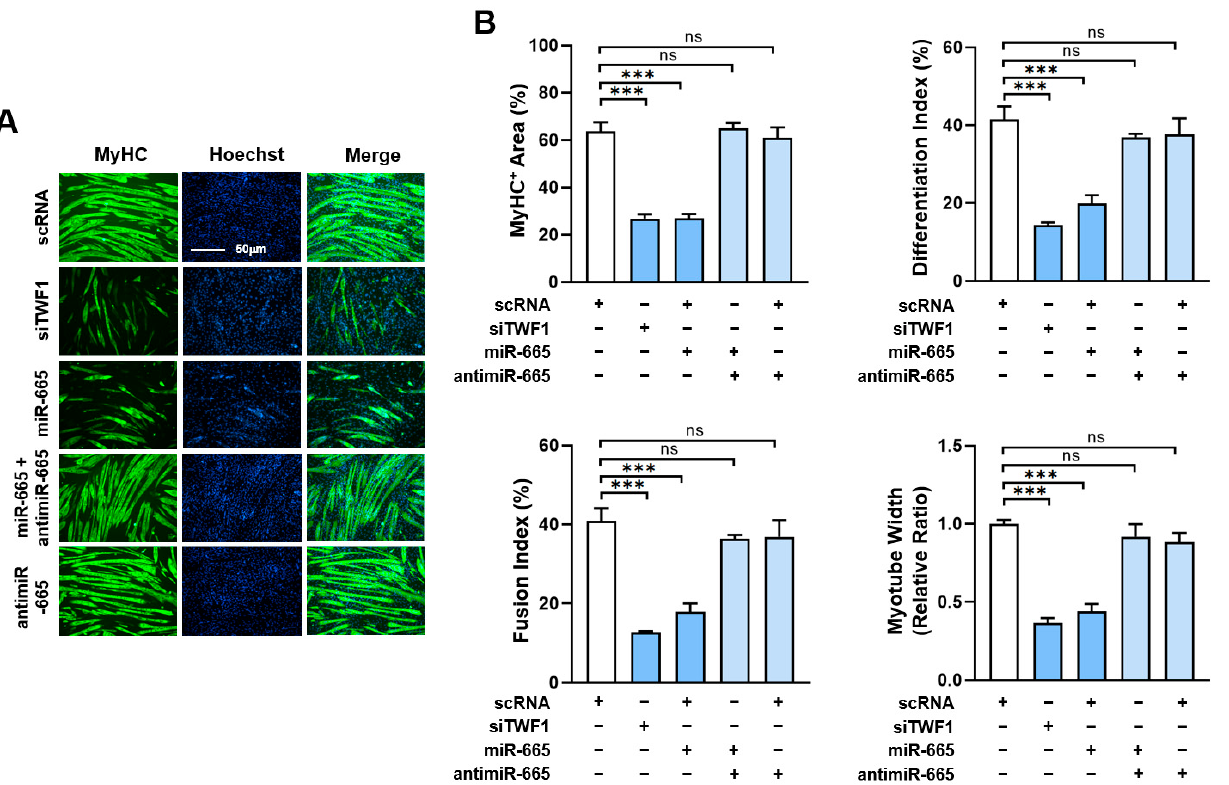
Figure 6. MiR-665-3p reduced myotube formation. C2C12 myoblasts were transfected with miR- 665 mimic, antimiR-665, siTWF1, or scRNA control (200 µ M) and then differentiated for five days. ( A ) Immunofluorescence staining (MyHC, green) was used to assess levels of differentiation of myoblasts. Nuclei were counterstained with Hoechst 33,342 (blue). Scale bar: 50 µ m. ( B ) Myotube formation was quantified based on the results of ( A ) for MyHC-positivity, differentiation indices, fusion indices, and myotube widths. Results are expressed as the means ± SEMs ( n = 3; *** p < 0.001). ns: no